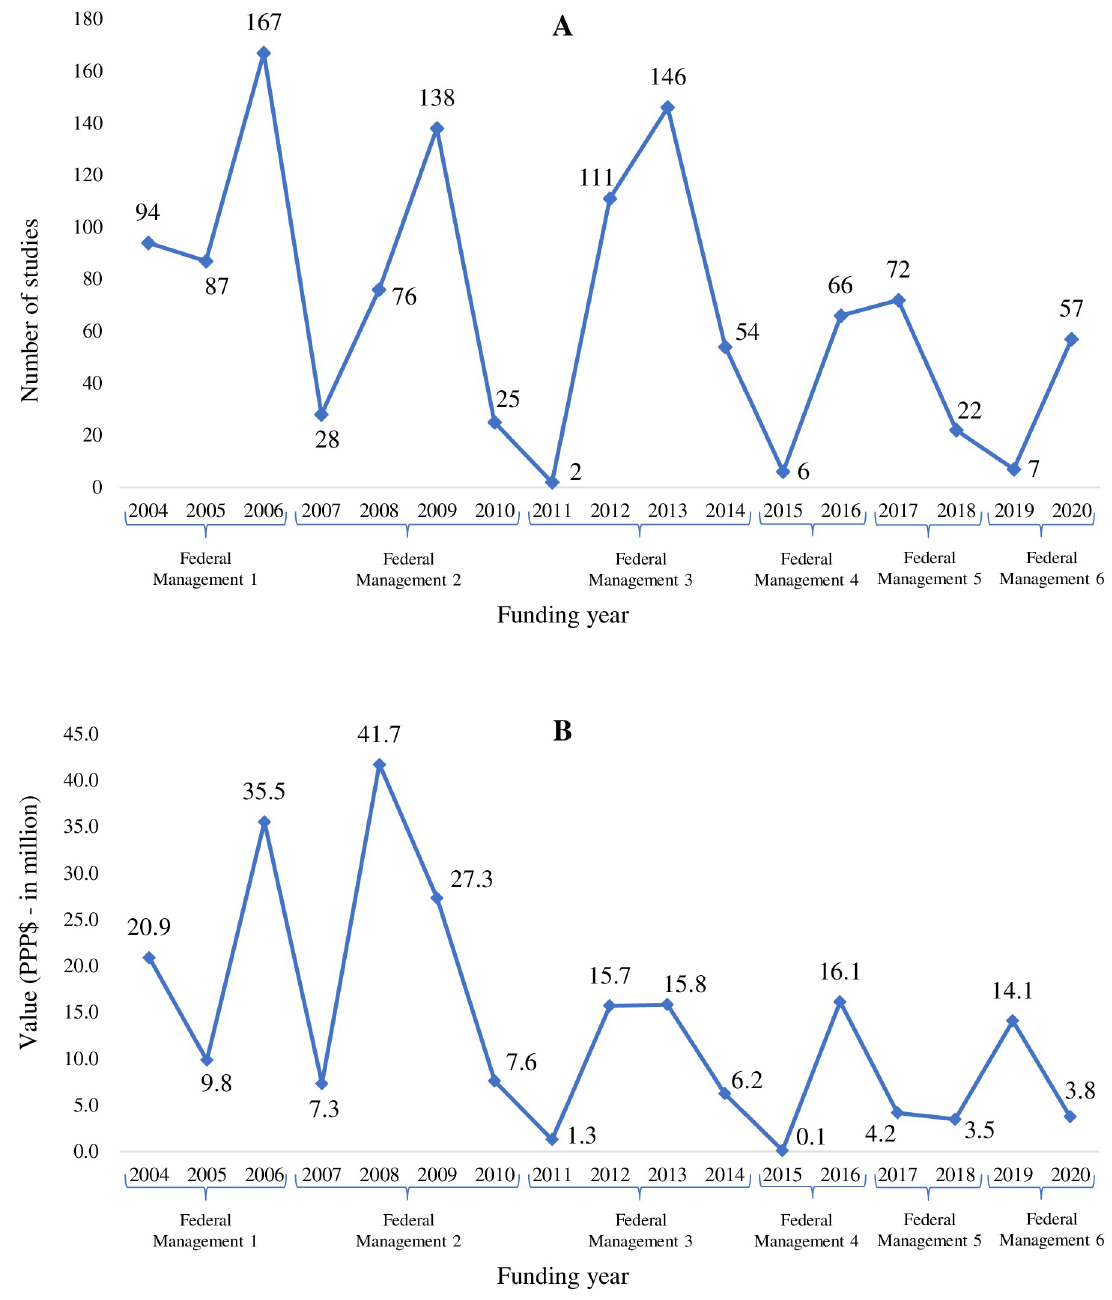
Fig 2. Distribution of surveys on neglected tropical diseases by year. (A) By number of studies. (B) By amount funded (PPP$). Brazil, 2004 to 2020. PPP$—Purchasing Power Parity–reference year 2021 (value in million). Source: based on data obtained from